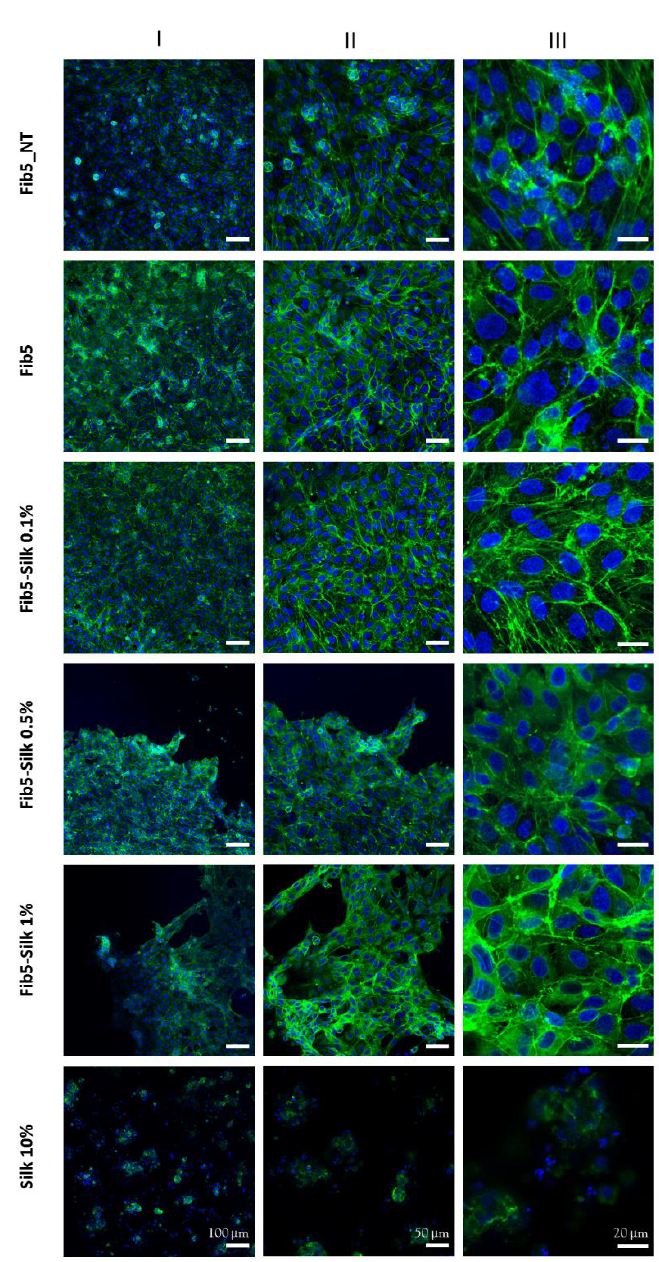
Figure 6. Confocal images of the scaffolds after seeding and culture with HUVECs under standard conditions. The actin filaments in the cell cytoskeleton are stained with phalloidin (in green) and the nuclei with DAPI (in blue). The left column ( I ) shows an overview, the middle column ( II ) represents the scaffolds at higher magnification, and the right column ( III ) shows a closer view of the morphology of the cells.